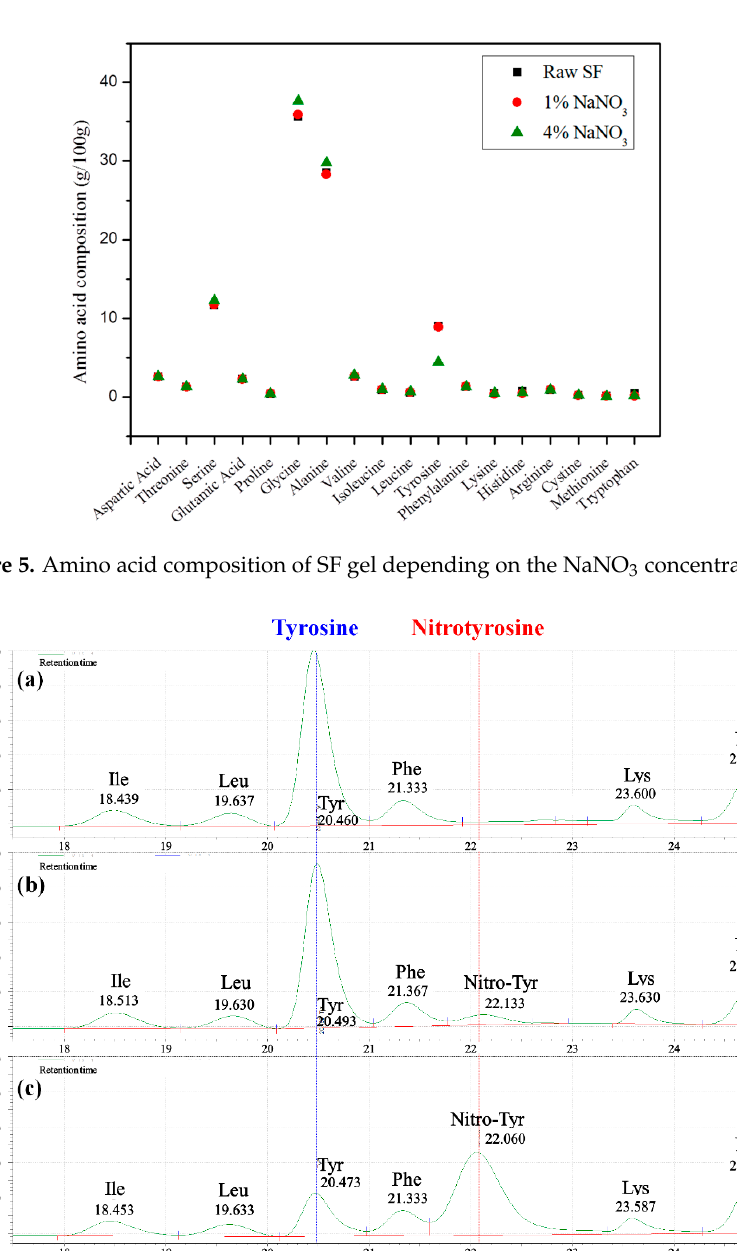
Figure 6. Contents of tyrosine and nitrotyrosine in SF gel depending on the NaNO 3 concentrations: ( a ) Raw SF; ( b ) 1% NaNO 3 ; and ( c ) 4% NaNO 3 .